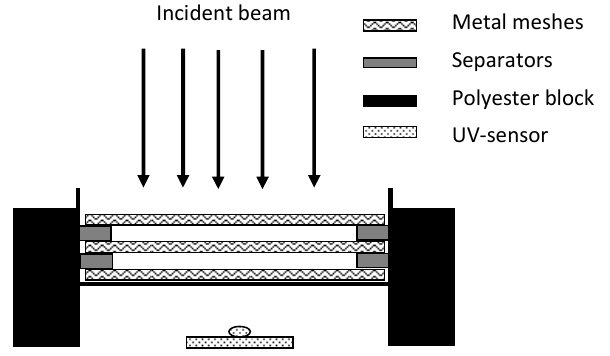
Figure 2. A schematic view of the experimental setup for light dis- tribution